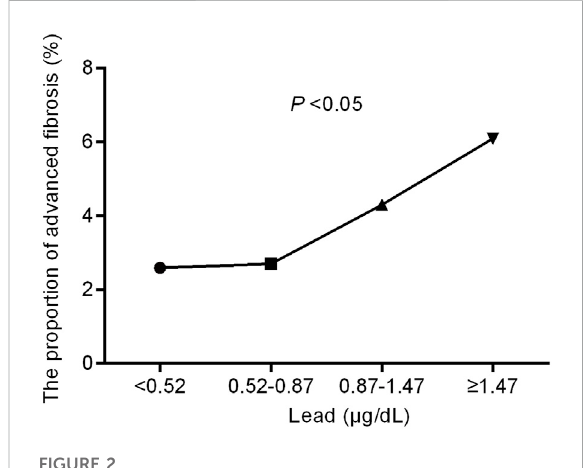
FIGURE 2 Rate of advanced fi brosis grouped by blood lead level.